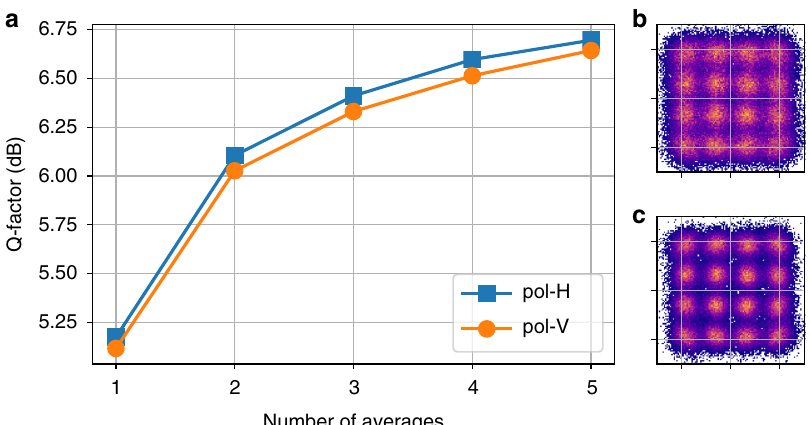
Fig. 3 Denoising. a The impact of de-noising by averaging over the training datasets on the Q-factor at SNR = 18.4 dB after 2800 km. b Received constellation before de-noising, and c after